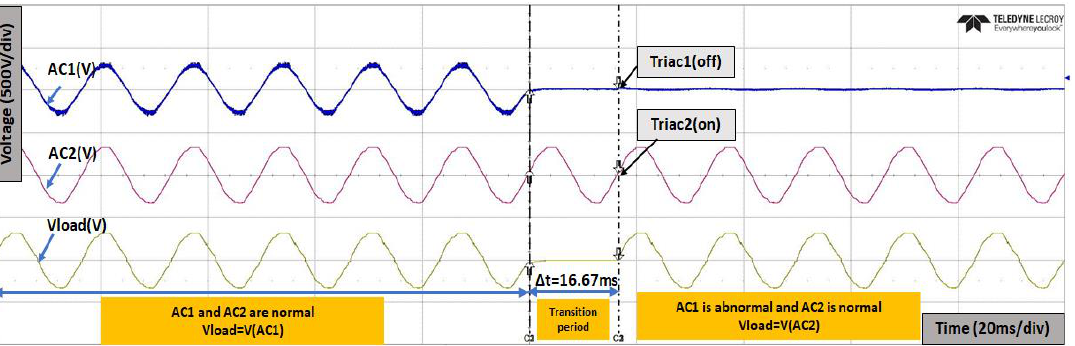
Figure 12. Experimental voltage waveforms and transition time calculations when the AC1 source is faulted at the point of zero-crossing.